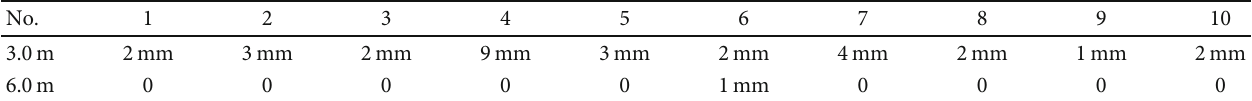
Figure 19: Deformation curve of roadway at the stage of stable stress. Table 4: Maximum separations of roof.